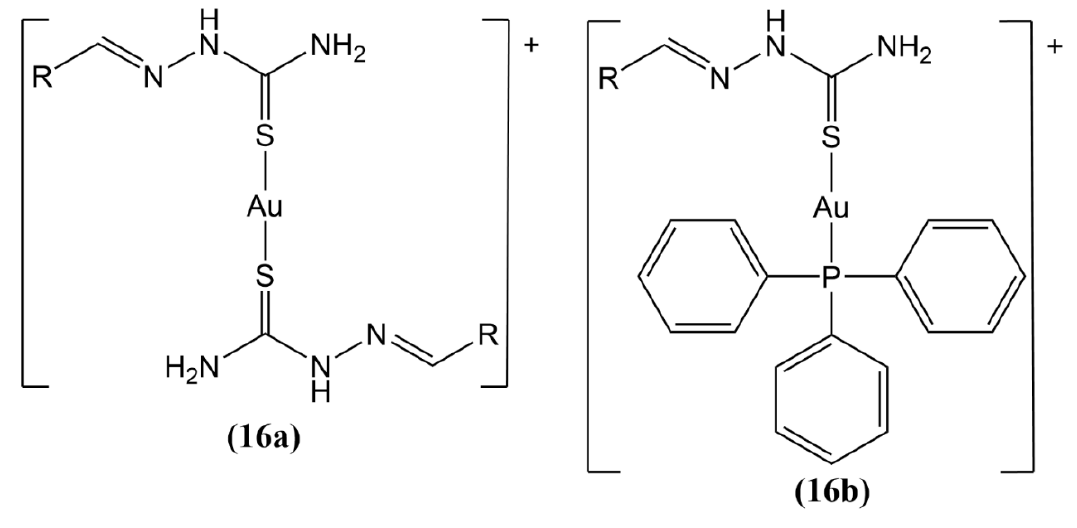
12 of 28 Figure 11. Gold(I) complexes with two ( 16a ) and one ( 16b ) aryl-thiosemicarbazone moieties. Gold(I) complexes with alkynyl and phosphine ligands are perspective scaffolds for metallodrug design and have recently been found to exert an inhibiting activity against TrxR in a joint experimental and computational study [69]. All the six synthesized complexes